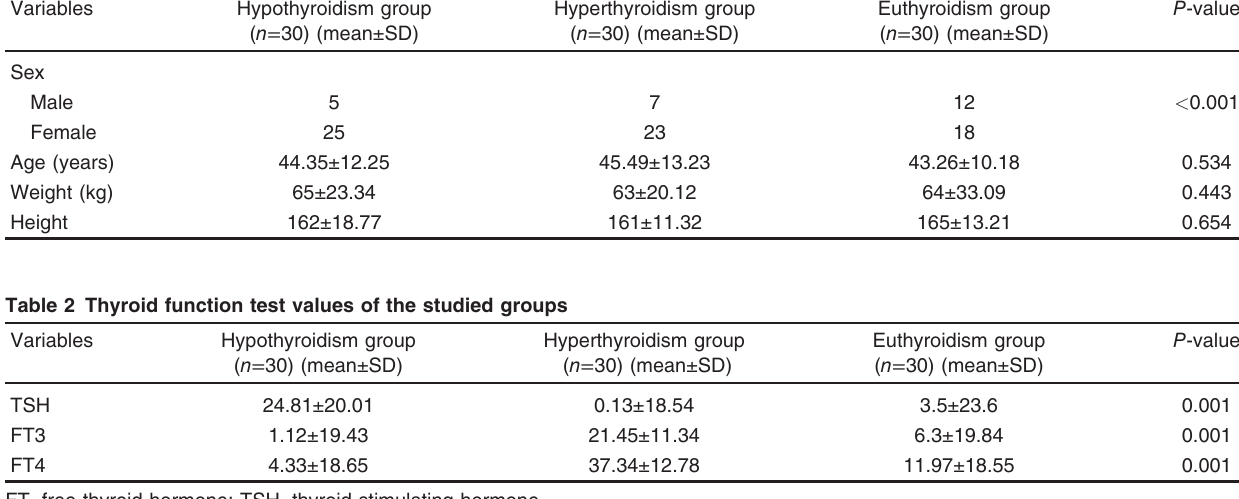
Table 1 Demographic parameters and thyroid function values of the participants